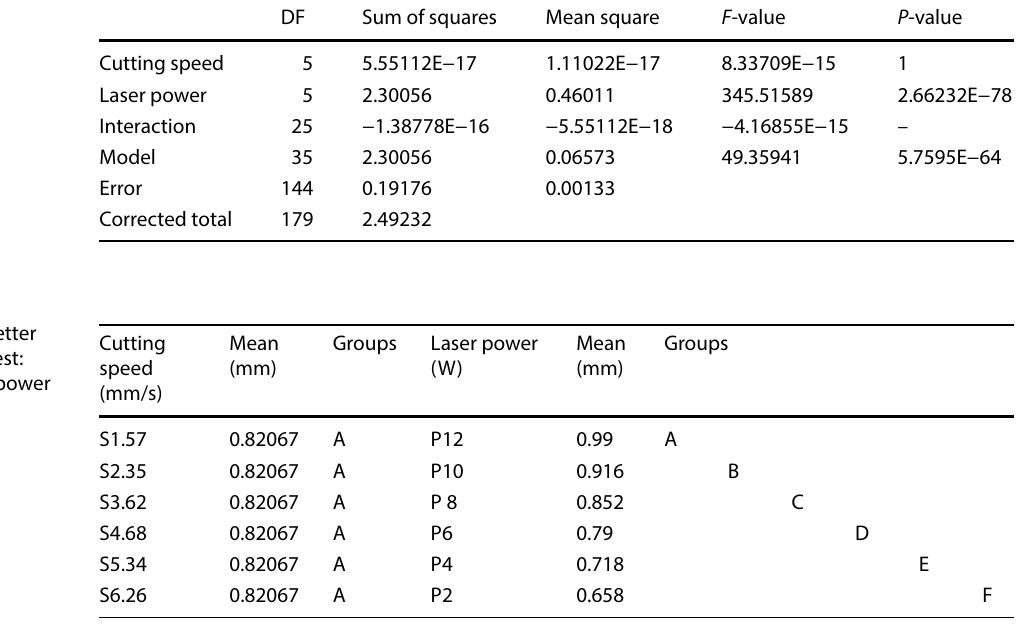
Table 25 Overall ANOVA results